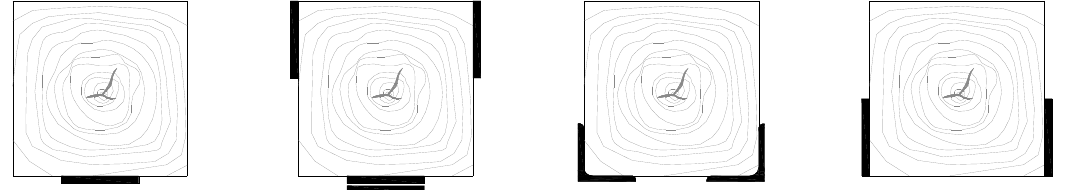
Figure 21. Examples of flexural reinforcement using externally-bonded or screwed stainless steel plates, strips or profiles.